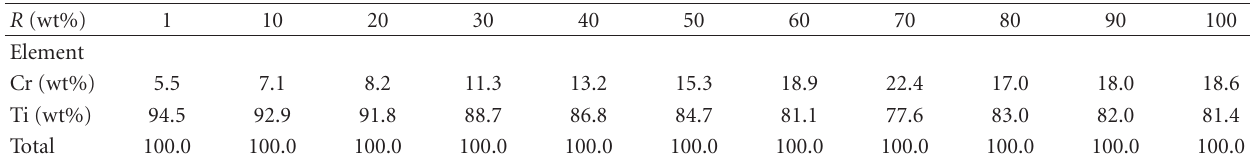
Table 1: Relationship between each element and di ff erent